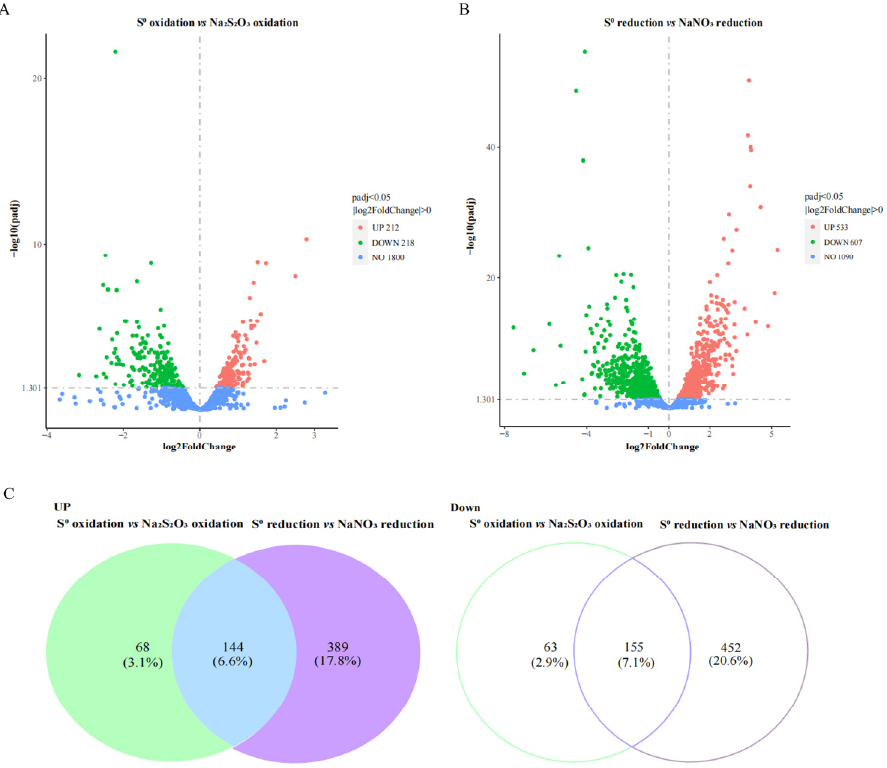
Figure 2. Volcano plots showing differentially expressed genes of S. indicum ST-419 under S 0 oxidation ( A ) and S 0 reduction ( B ) compared to the control. ( C ) Venn diagrams showing the differential expression gene occurring in both conditions including upregulated (Left) and downregulated (Right). % represents the proportion of differential expression genes shared in the two conditions among the CDS of the